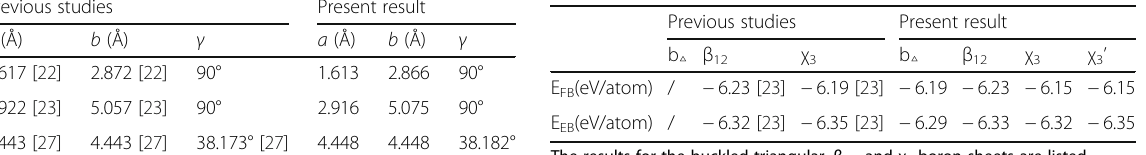
Table 2 Average energy for boron atoms in the freestanding ( E FB ) and epitaxial ( E EB ) boron sheets on the Ag(111)